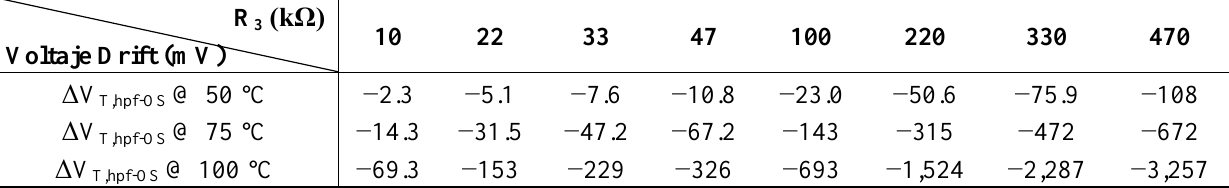
Table 9. Output voltage drifts ΔV (mV) for the HPF in Figure 4, 25 °C point of reference. T,hpf-OS R (kΩ) 3 Voltaje Drift (mV)